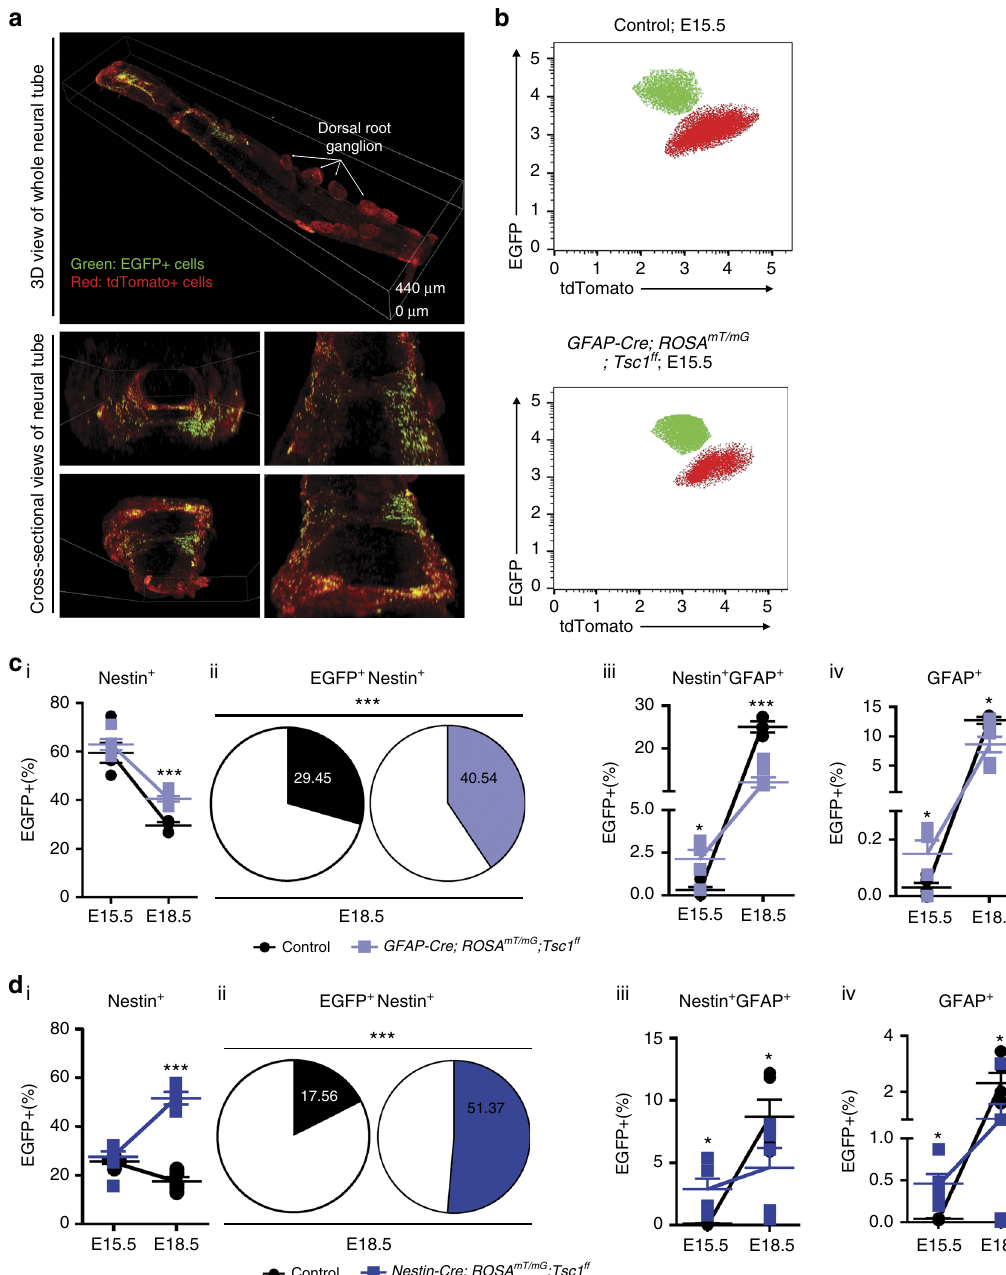
Fig. 5 Loss of Tsc1 delays the differentiation of NSCs and RGCs. a Confocal microscopy of EGFP-positive (EGFP + ) and tdTomato-positive (tdTomato + ) NT cells in a ROSA mT/mG mouse NT. Maximum intensity projections from Z-stacks is shown. b – d FACS of EGFP + NT cells in b , c GFAP-Cre;ROSA mT/mG (control) vs. GFAP-Cre;ROSA mT/mG ;Tsc1 ff embryos or d Nestin-Cre;ROSA mT/mG (control) vs. Nestin-Cre;ROSA mT/mG ;Tsc1 ff embryos. b Representative FACS plots of EGFP + or tdTomato + NT cells. c , d GFAP-Cre;ROSA mT/mG (control-black) vs. GFAP-Cre;ROSA mT/mG ;Tsc1 ff embryos (blue) ( c ) or Nestin-Cre;ROSA mT/ mG (control-black) vs. Nestin-Cre;ROSA mT/mG ;Tsc1 ff embryos (blue) ( d ). (i) Change in the percentages of EGFP + nestin + NT cells from E15.5 to E18.5 embryos. (ii) Charts representing EGFP + nestin + NT cells at E18.5. (iii, iv) Change in the percentages of (iii) EGFP + nestin + GFAP + or (iv) EGFP + GFAP + NT cells from E15.5 to E18.5 embryos. Data represent means ± s.e.m.. Error bars are de fi ned as means + s.e.m. * P ≤ 0.05, *** P ≤ 0.001 t -test. Data are representative of two experiments, n GFAP-Cre;ROSAmT/mG (E15.5 n = 5, E18.5 n = 3), n GFAP-Cre;ROSAmT/mG;Tsc1ff (E15.5 n = 5, E18.5 n = 7) ( c (i – iv)); n Nestin-Cre; = 4, E18.5 n = 5), n = 7, E18.5 n = 5) ( d (i, ii)); n = 4, E18.5 n = 5), n Nestin-Cre;ROSAmT/mG;Tsc1ff (E15.5 n Nestin-Cre;ROSAmT/mG (E15.5 n Nestin- ROSAmT/mG (E15.5 n = 6, E18.5 n = 5) ( d (iii, iv)) embryos Cre;ROSAmT/mG;Tsc1ff (E15.5 n GFAP-Cre driver to remove the fl oxed Tsc1 allele from the NSCs cells (radial glial progenitors (RGCs)) 23, 55, 56 ; (3) nestin- and and early and late neuronal progenitors, respectively, since both NS-tubulin-expressing cells (neuronal progenitors) 57 ; (4) GFAP- promoters are active in LAM and angiomyolipoma (Fig. 1). We expressing cells (glial precursors); and (5) NS-tubulin-expressing compared control- and mutant-EGFP + cells: (1) nestin-positive cells (differentiated neurons) (Fig. 5, Supplementary Fig. 7A – C, and Supplementary Table 4). cells, representing NSCs 23, 55 ; (2) nestin- and GFAP-expressing | DOI: 10.1038/s41467-017-01845-1 |